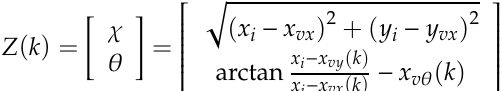
as Figure A1. Mathematics 2020 , 8 , x FOR PEER REVIEW